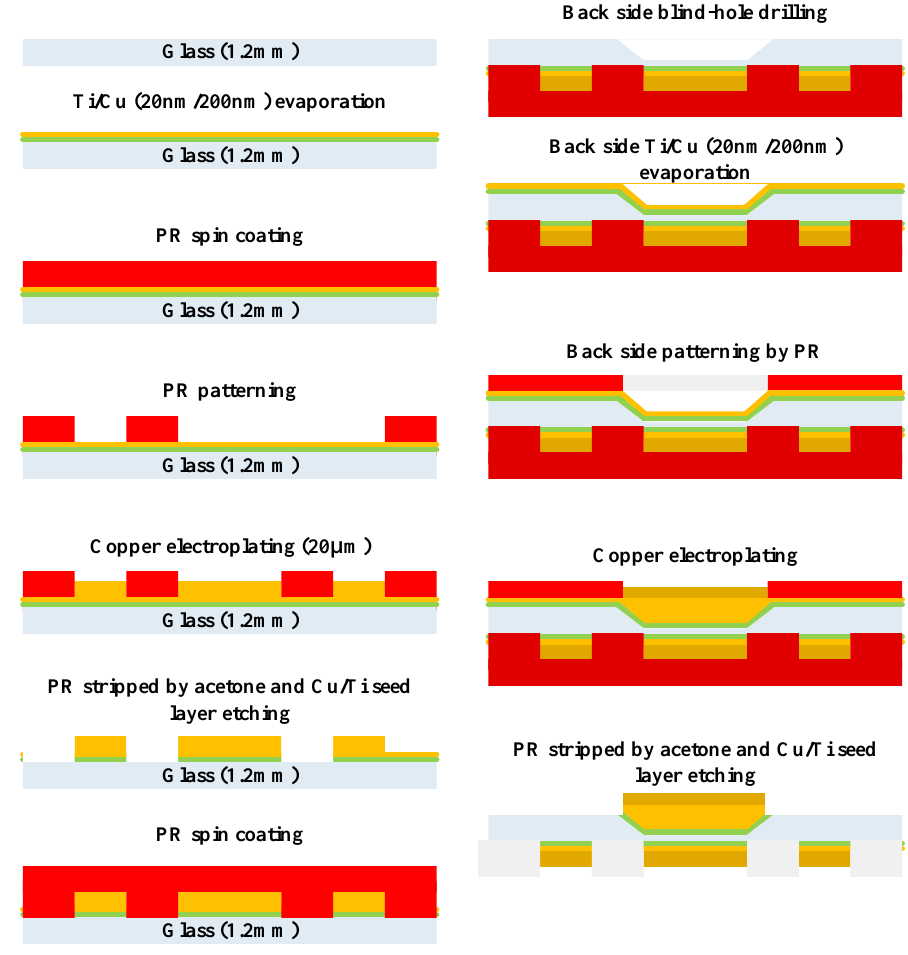
Figure 5. Fabrication process for creating a single layer transparent atom chip with heat dissipation design on the backside